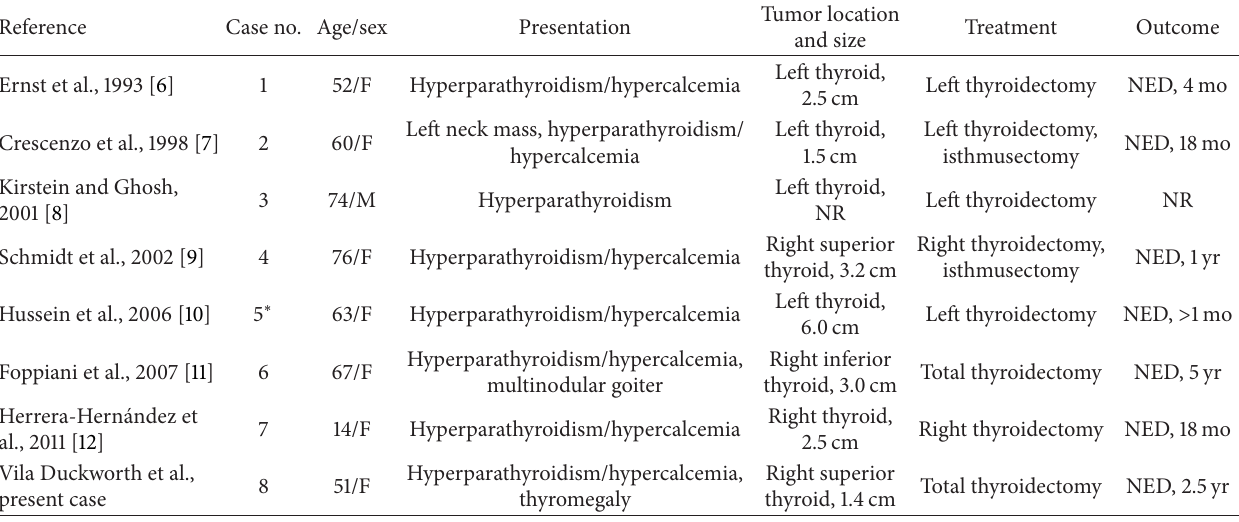
Table 1: Literature review of published intrathyroidal parathyroid carcinoma